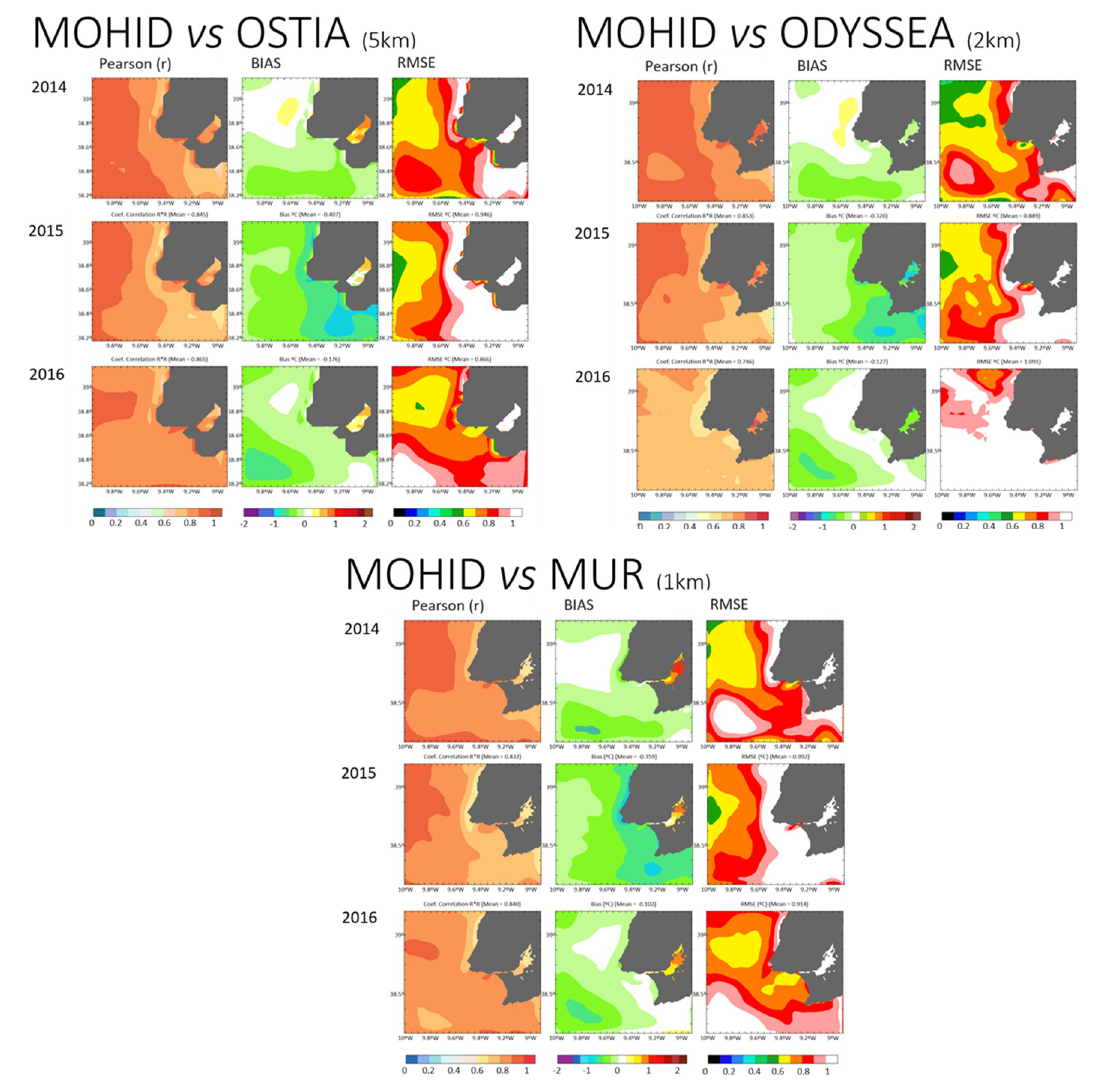
Figure10. Spatialdistributionofthedi ff erencesbetweenMOHIDandthethreesatelliteproducts(OSTIA, Figure 10. Spatial distribution of the differences between MOHID and the three satellite products ODYSSEA, and MUR) for the Pearson correlation coe ffi cient ( r ), BIAS and RMSE , between (OSTIA, ODYSSEA, and MUR) for the Pearson correlation coefficient ( r ), BIAS and RMSE , between 2014–2016.